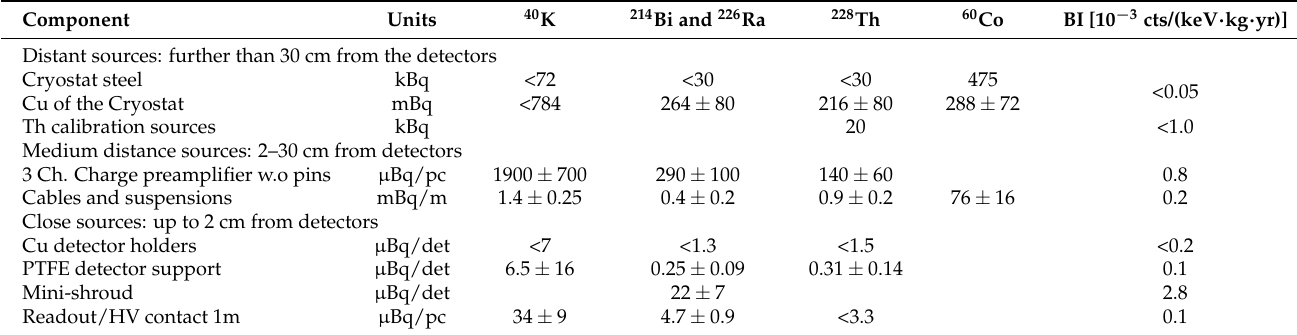
Table 2. Gamma screening results for materials adopted in the Ge detector array. Upper limits are 90% C.L., while uncertainties are 1 σ values. The estimated contributions to the BI at Q ββ are after anti-coincidence but before LAr and PSD. Component Units 40 K 214 Bi and 226 Ra 228 Th 60 Co BI [10 − 3 cts/(keV · kg · yr)] Distant sources: further than 30 cm from the detectors Cryostat steel kBq